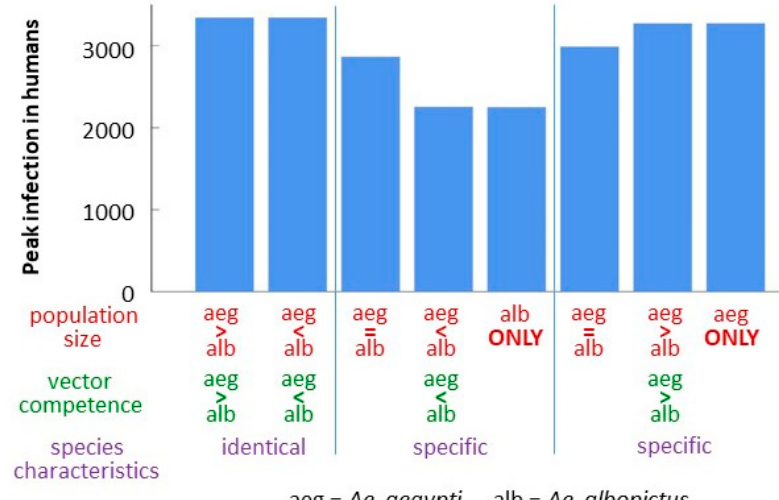
Figure 6. Number of human cases at the peak with species and strain specific parameters. Total mosquito recruitment: ρ max = 5000 / host / year. Equal recruitment ( aeg = alb ) : ρ max = 2500 / species. Asymmetric recruitment ( aeg > alb or alb > aeg ): high ρ max = 4990, low ρ max = 10. b , β parameters varied to reflect di ff erent Chikungunya virus strains ([ b , β ] = [0.65, 0.9] for species with greater vector competence; [0.5, 0.75] for lower). Species characteristics (“specific”) varied were days between human bloodmeals and mortality rates ( Ae. aegypti: α = 3d, µ 22 = 0.08, µ sl = 0.006; Ae. albopictus: α = 4d, µ 22 = 0.06, µ sl = 0.08). Ae. aegypti parameter values were used for identical species characteristics. All runs: γ 22 = 0.25, γ sl = 0.015, T mean = 22 °C, t crit = 200, Temp c = 22 °C.